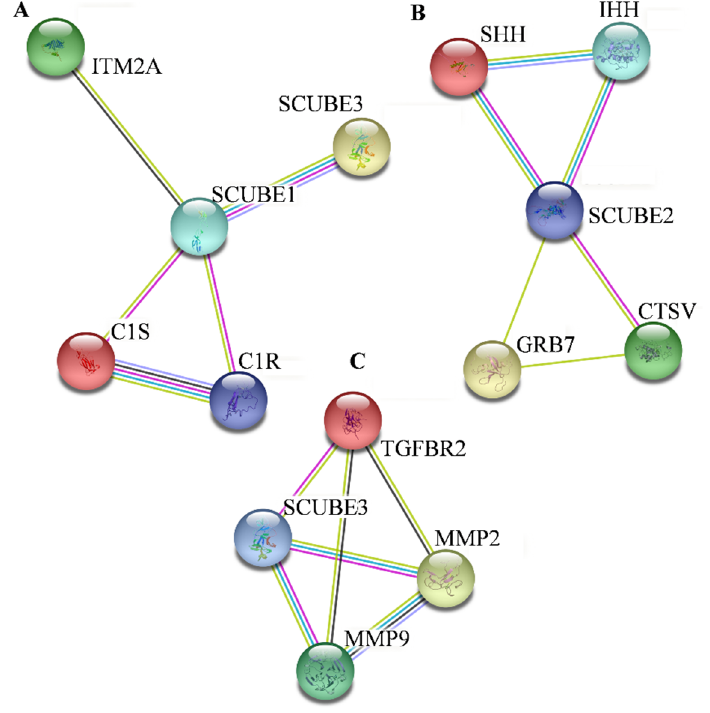
Figure 4. Protein–protein interaction network with SCUBE family and other proteins on STRING database. These interactions with other proteins were experimentally studied. ( A ) SCUBE1; ( B ) SCUBE2; ( C ) SCUBE3. Table 2. Association of SCUBE (1, 2, or 3) with other proteins and putative outcomes. SCUBE Family